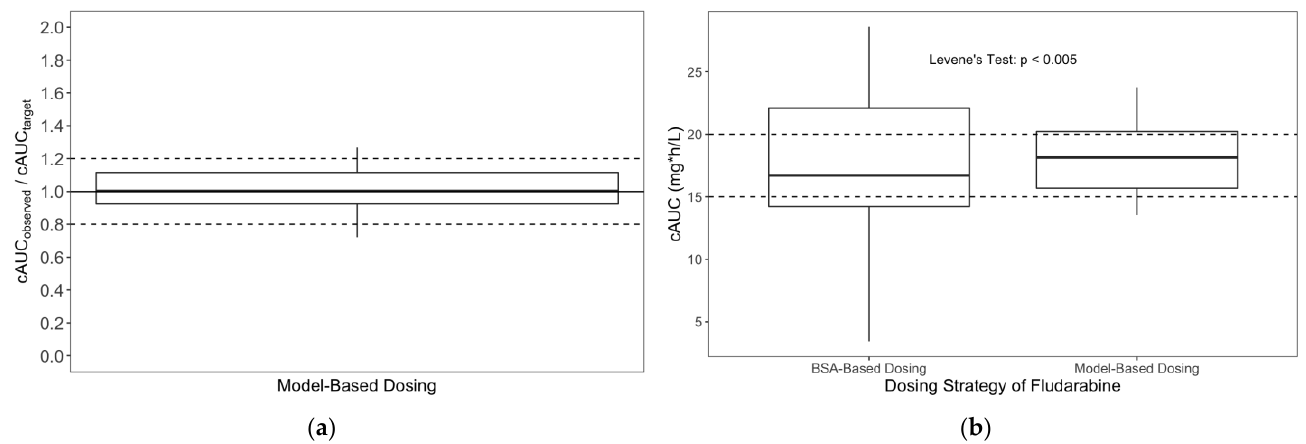
Figure 2. ( a ) Model performance presented as the ratio of cAUC observed /cAUC target in 24 subjects who received MBD of f-ara-a prior to HCT. ( b ) A comparison of the variability in cAUC between subjects undergoing BSA-based dosing and pre-emptive MBD of f-ara-a prior to HCT.